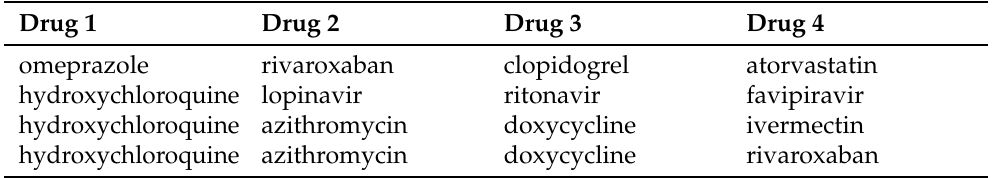
Table 4. Cliques of size four detected from clinical trials association network.